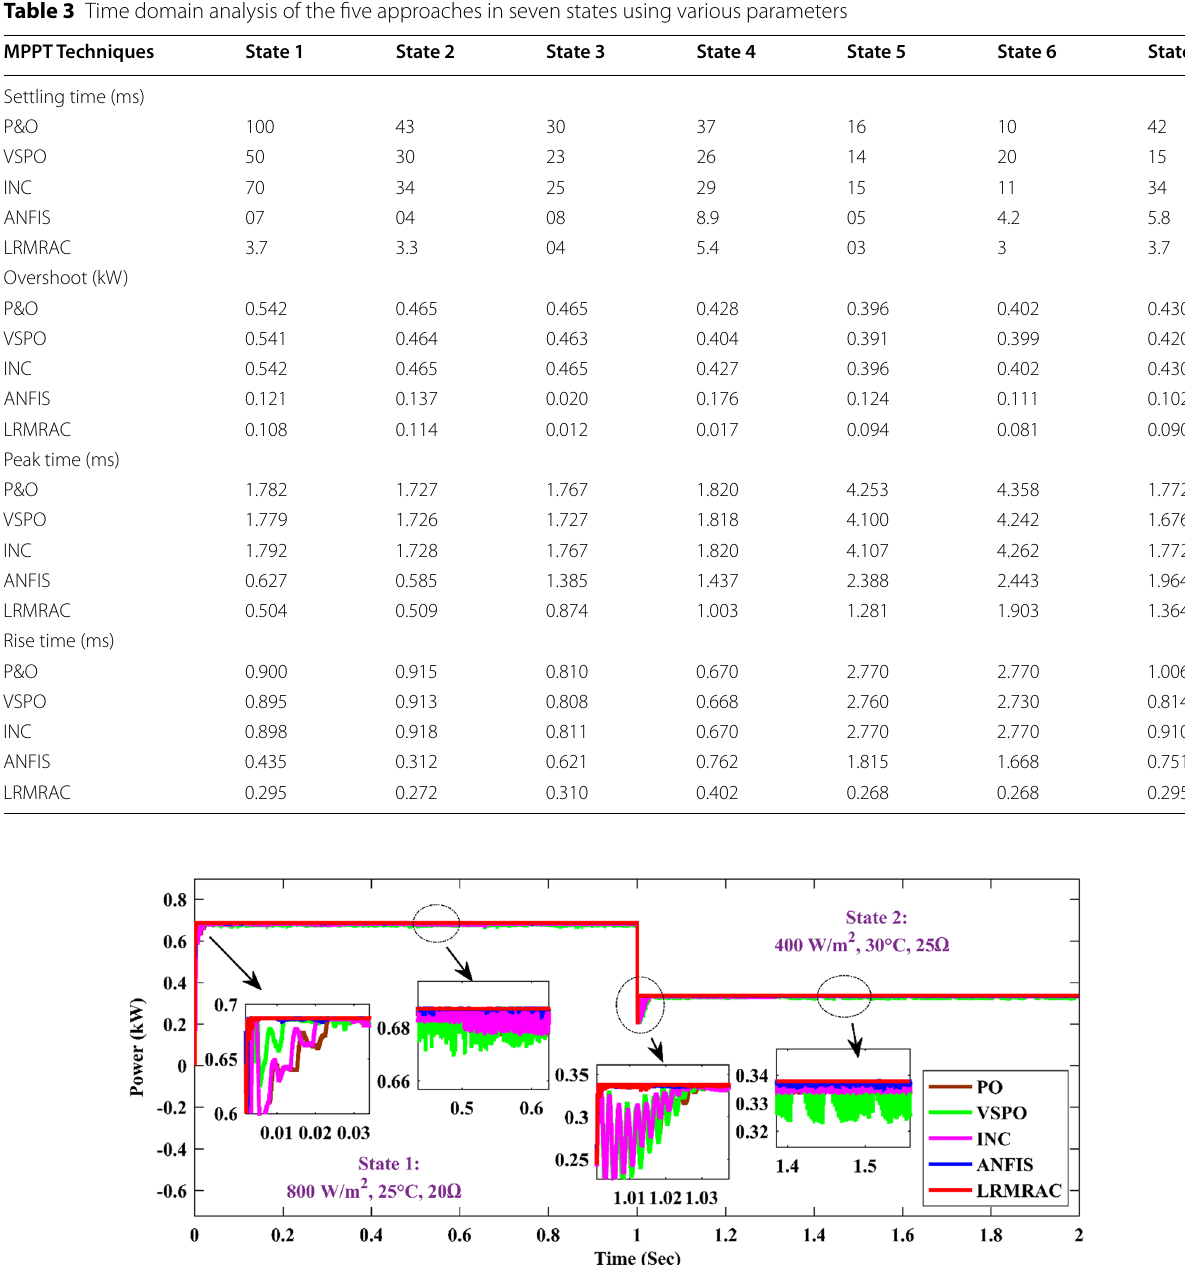
Fig. 19 PV power behaviours of the five MPPT controllers under slow variations of radiation, temperature and load